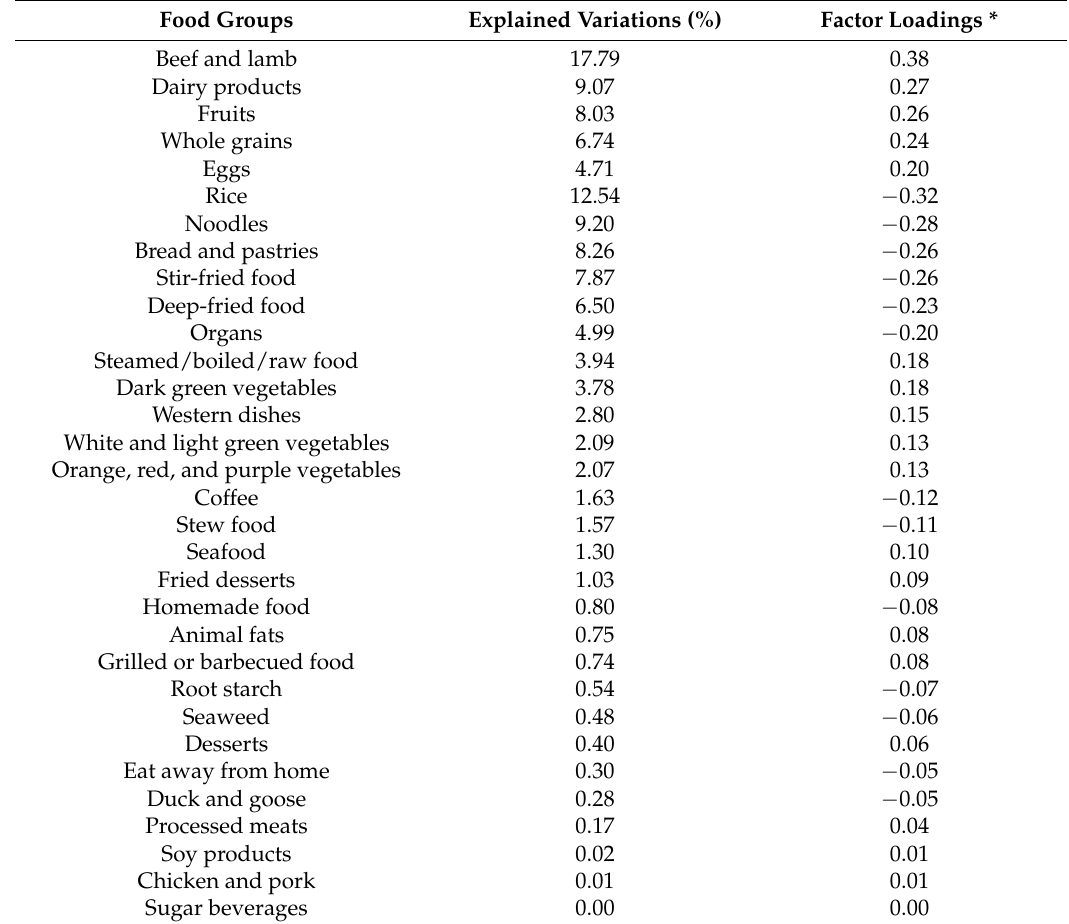
Table 3. Percentage of food variations explained by the first dietary pattern scores and factor loadings of all 32 food groups derived from reduced rank regression in all participants ( n =